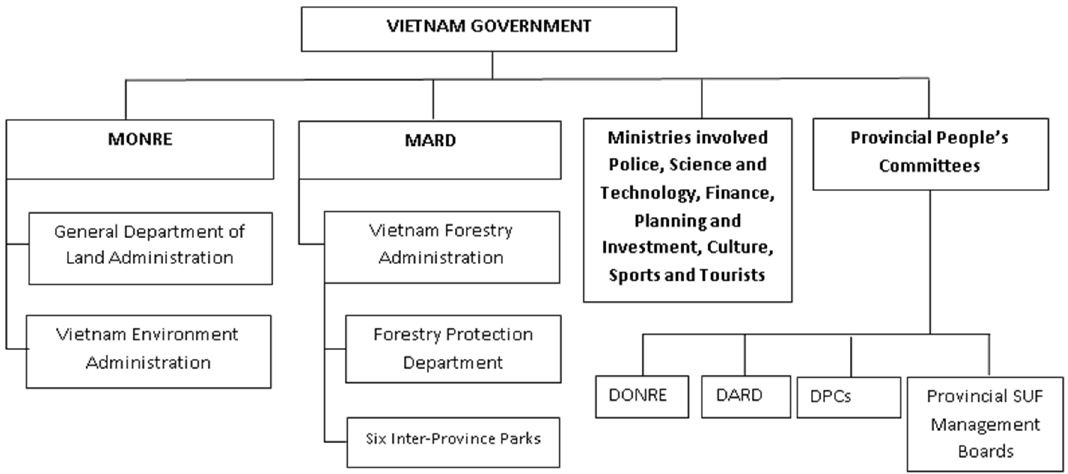
Figure 1. Vietnamese state organizations responsible for biodiversity and nature conservation (Source: Adapted from Ministry of Natural Resource and Environment 2011).